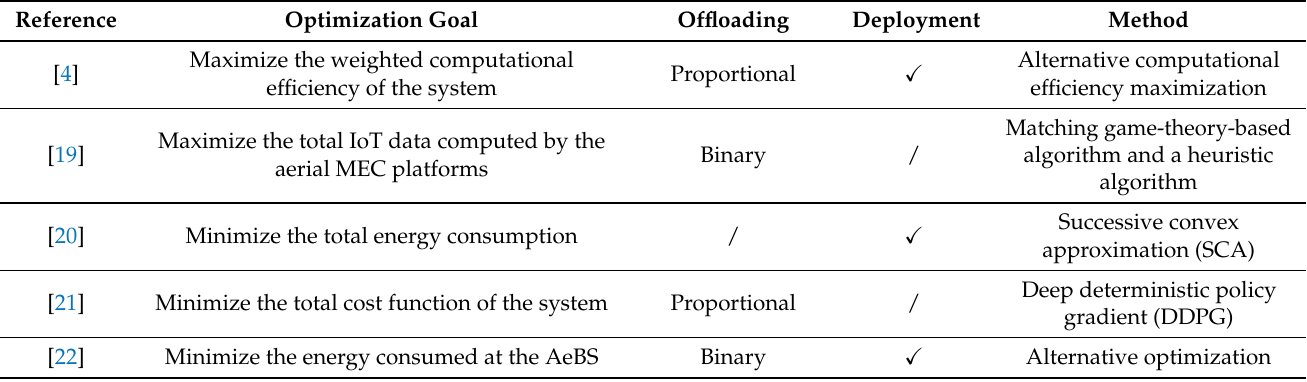
Table 1. Comparison between our work and the existing